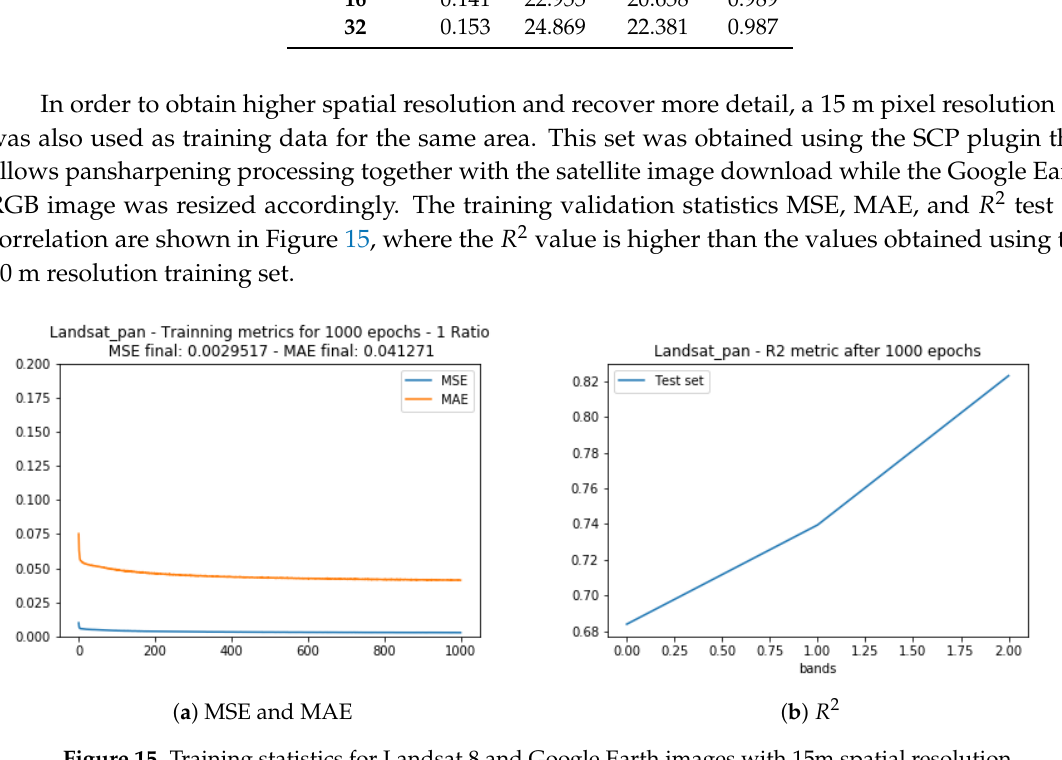
Figure 15. Training statistics for Landsat 8 and Google Earth images with 15m spatial